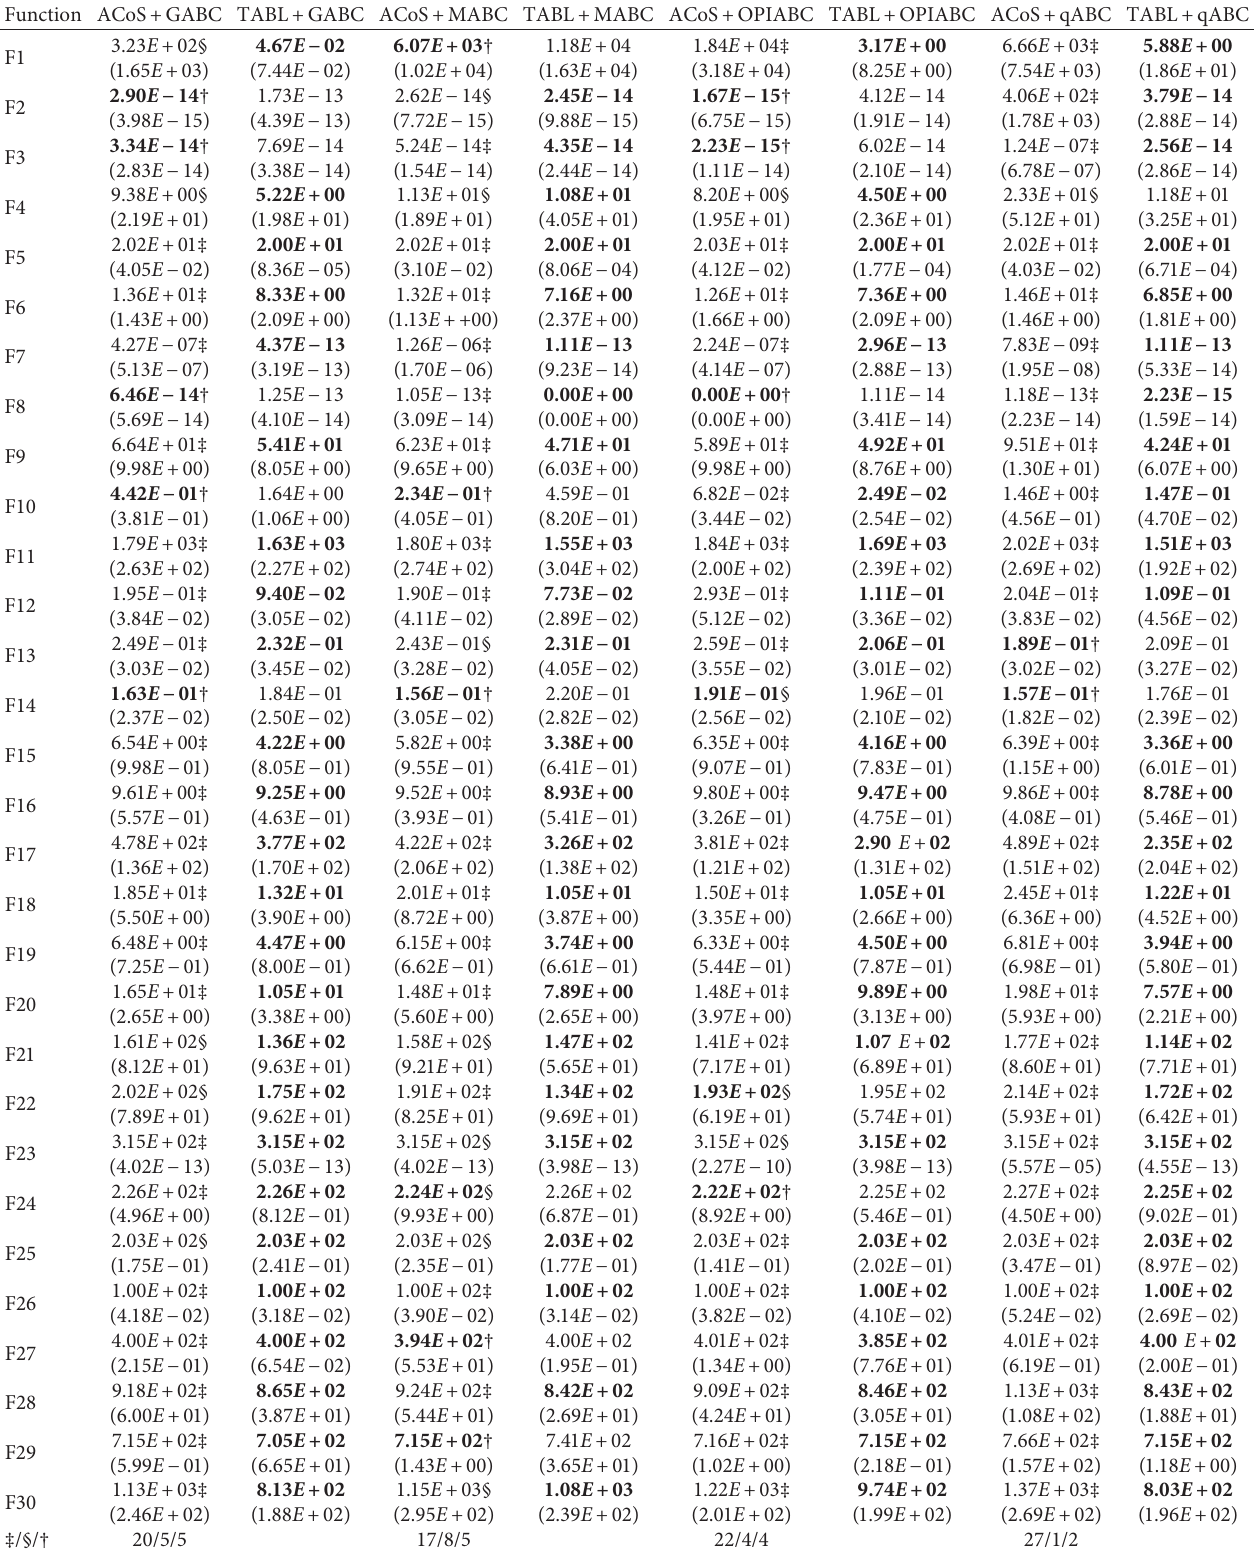
Table 6: The statistical results (mean (std)) of ACoS +GABC vs. TABL+GABC, ACoS +MABC vs. TABL+MABC, ACoS +OPIABC vs. TABL+OPIABC, and ACoS+qABC vs. TABL +qABC over 51 independent runs on the CEC2014 benchmarks with 30 D